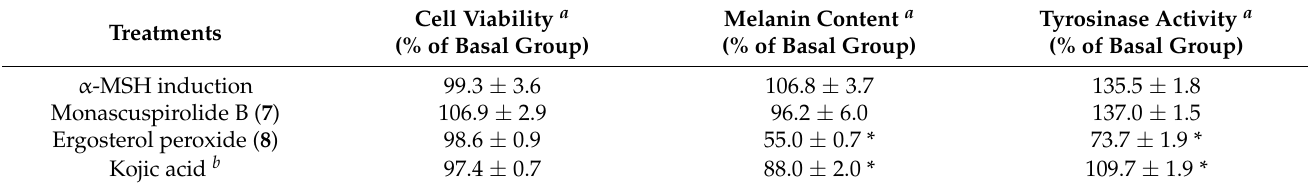
Table 2. Anti-melanogenic activities of test compounds in the mouse melanoma cell line B16-F10. Treatments Cell Viability a Melanin Content a (% of Basal Group) (% of Basal Group)